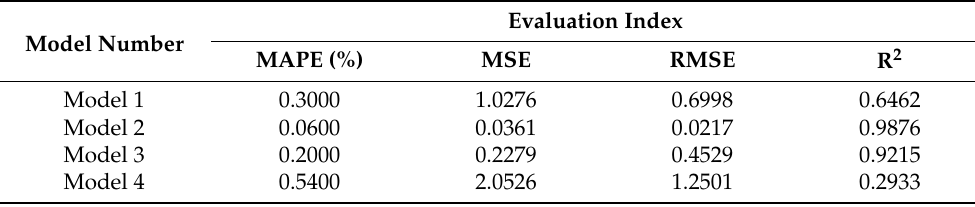
Figure 8. Trend displacement prediction results for different training sets: ( a ) prediction results of Model 1; ( b ) prediction results of Model 2; ( c ) prediction results of Model 3; ( d ) prediction results of Model 4. Table 3. Evaluation index values of different models in trend displacement.